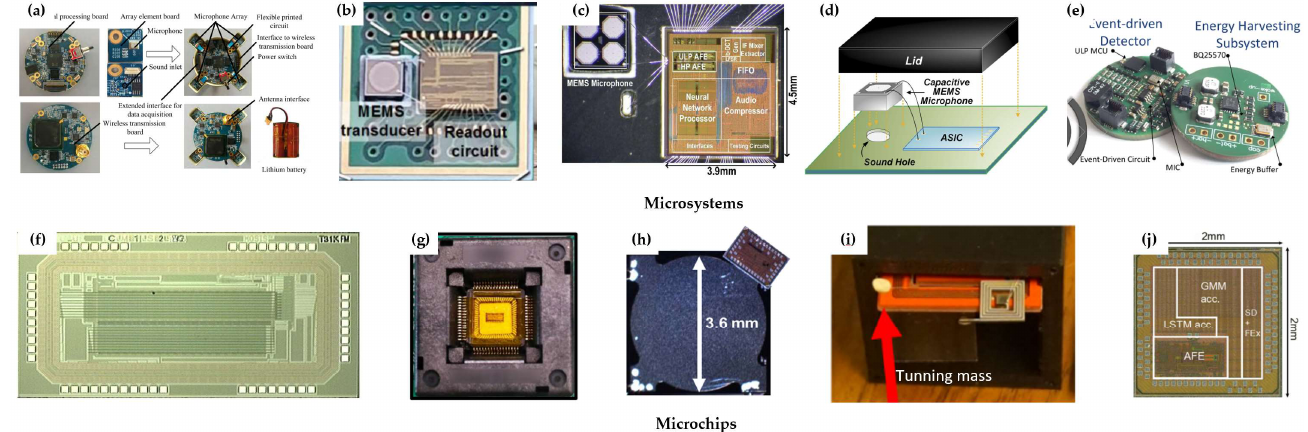
Figure 17. Acoustic wake-up microsystems and microchips in Architecture 1. (a)-(e) Microsystems. (f)-(j) Microchips. [22,61–69].